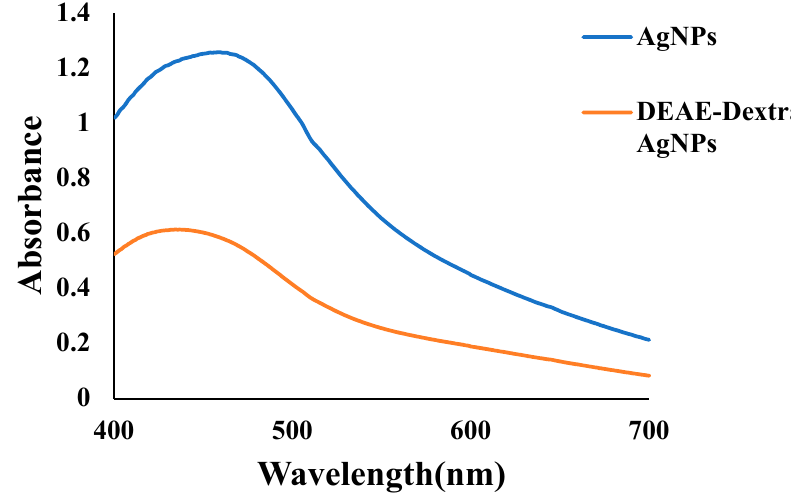
Figure 1. UV analysis of AgNPs and DEAE-Dextran AgNPs.